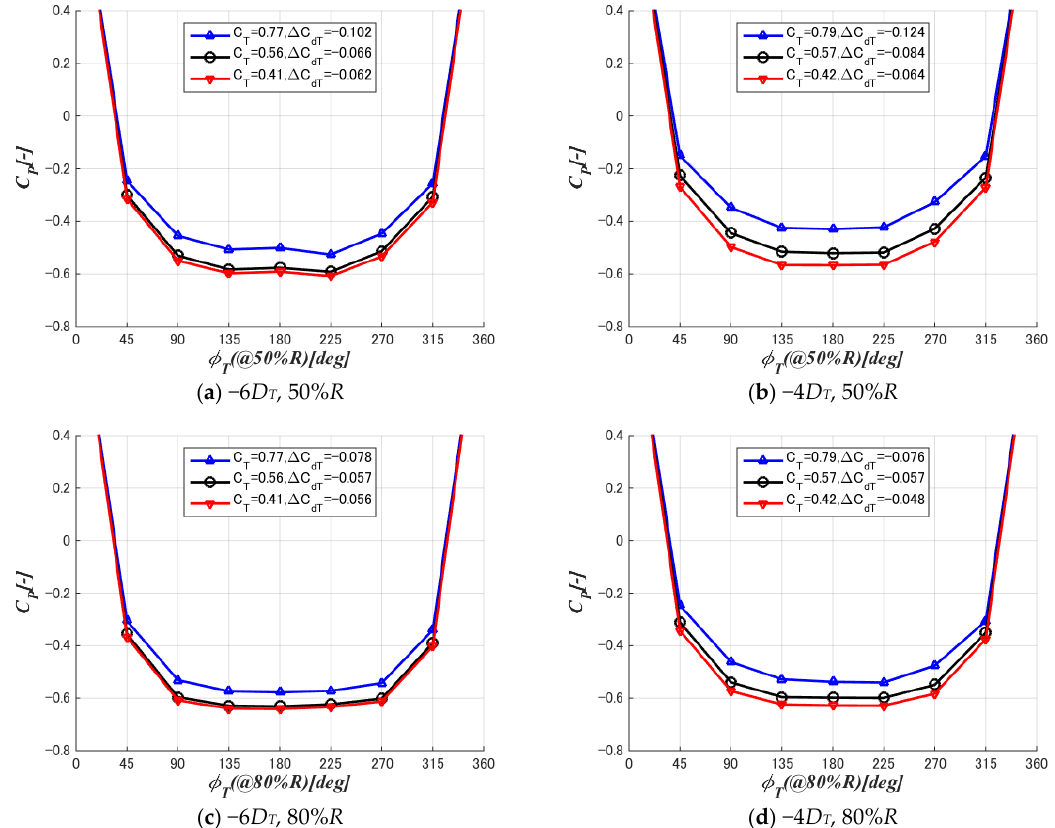
Figure 6. Distribution of the pressure coefficient on the dummy tower in typical cases.